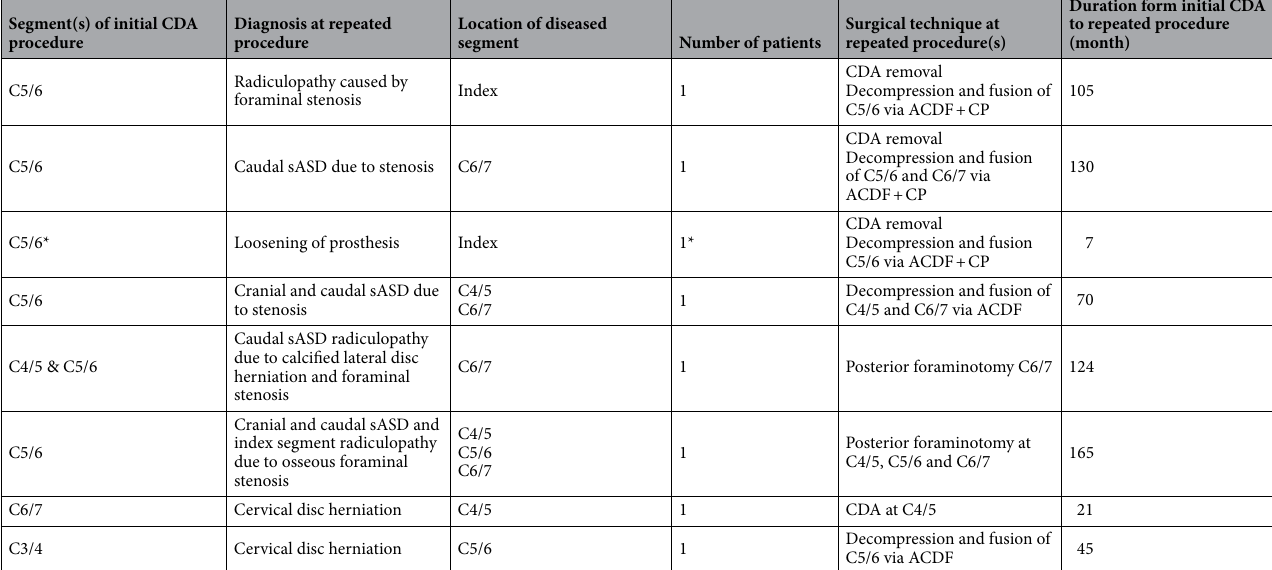
Table 5. Repeated procedures. *Patient developed sASD at C4/5 and underwent ACDF + CP 6 years after CDA